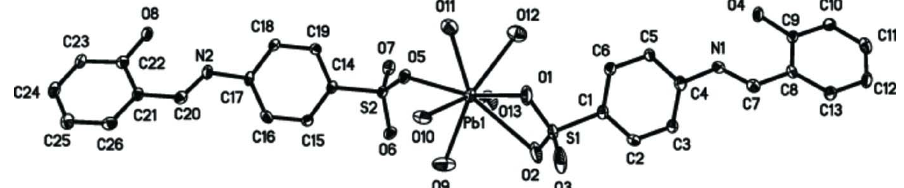
Figure 1 The molecular structure of (I) showing 50% displacement ellipsoids. Pentaaquabis[4-(2-hydroxybenzylideneamino)benzenesulfonato]lead(II) Crystal